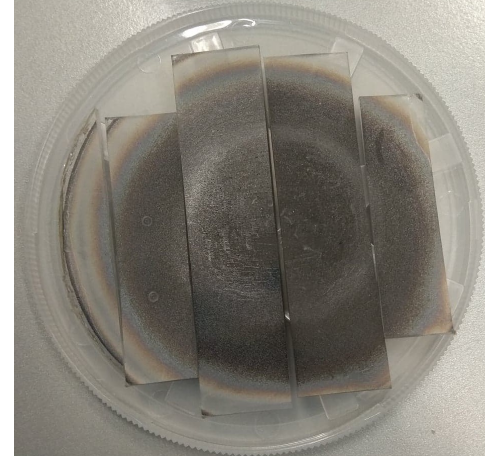
Figure 3: Diced strips of successfully transferred NCG/PDMS Figure 4: (a) NCG/PDMS in PLA mould before encapsulation; (b) NCG/PDMS after complete PDMS